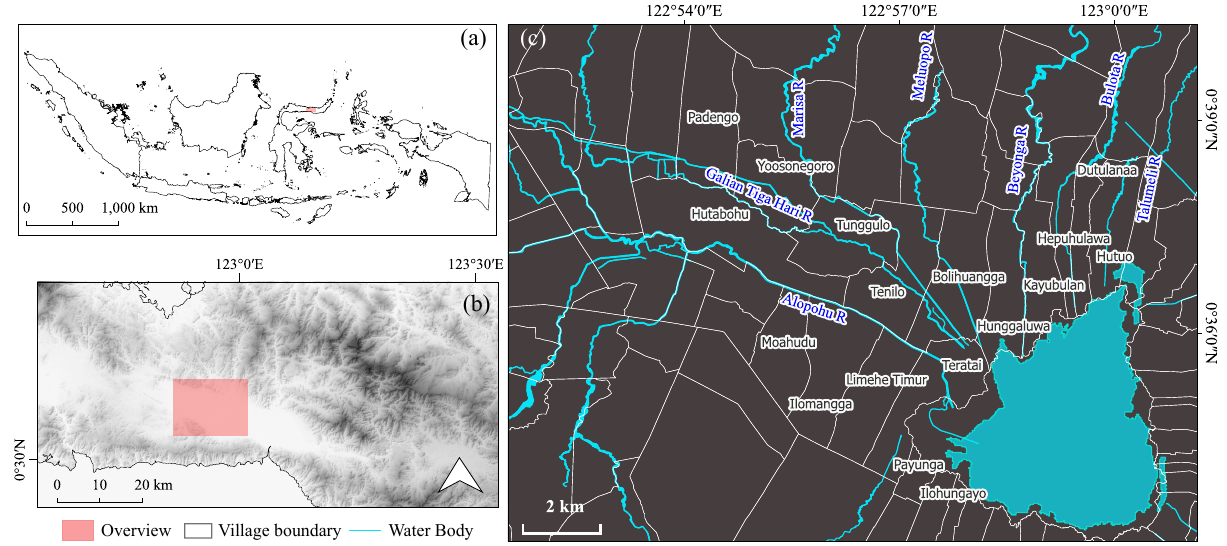
Figure 2. Study area: ( a , b ) overview of the study area and ( c ) Limboto Lake and flowing